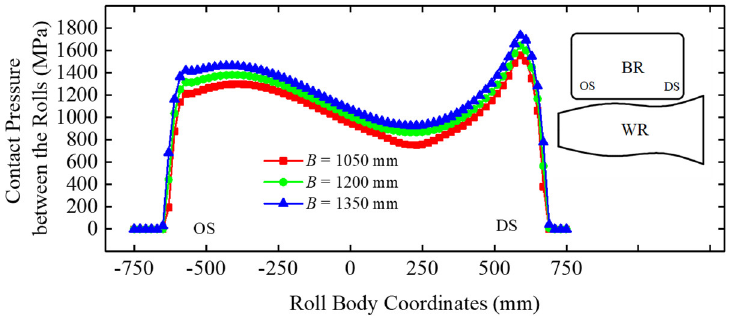
Figure 5. Contact pressure between the rolls at different strip widths B ( S = 0 mm, q = 12.5 kN/mm).